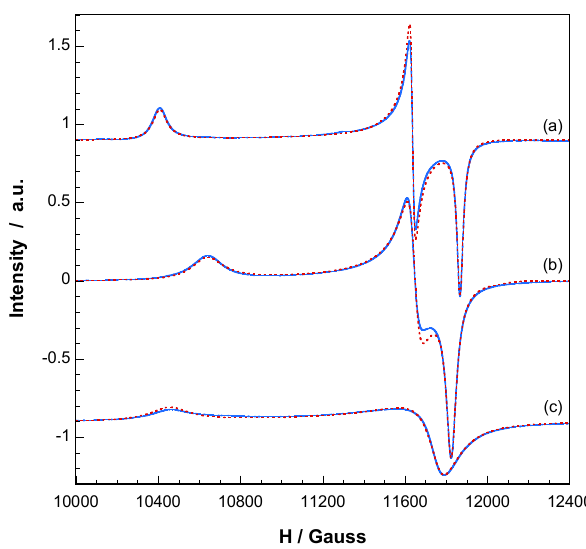
Figure 5. Q-band EPR spectra recorded at room temperature on polycrystalline samples of ( a ) compound 1 , ( b ) heated at 90 °C and ( c ) heated at 200 °C.